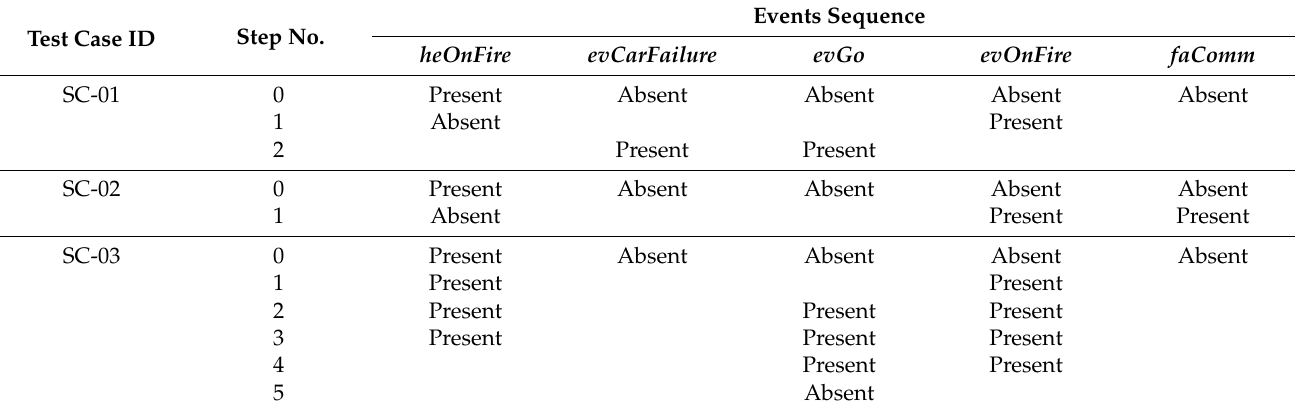
Table 4. Part of the scenarios automatically generated by the proposed ATG methodology as the test cases for the